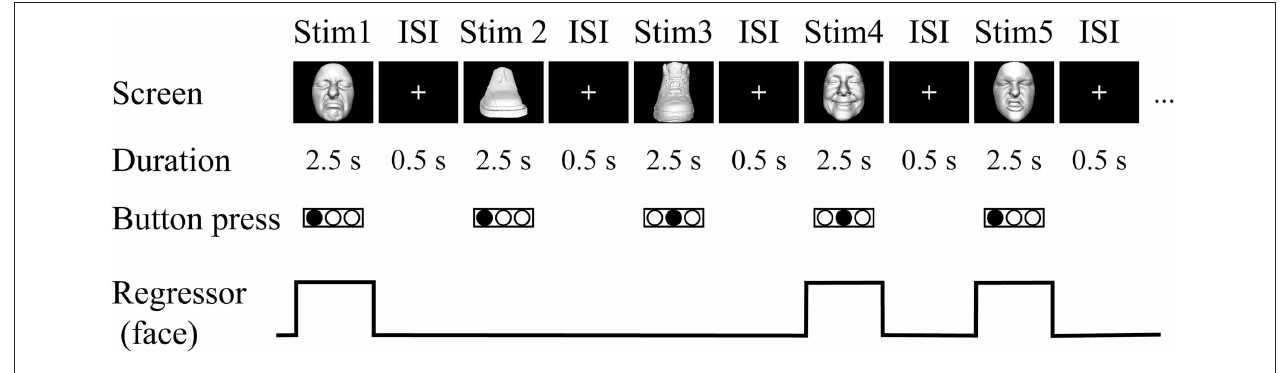
FIGURE 2 | Visual task. In the fMRI experiment, sighted subjects were instructed to identify the three subordinate levels for both object categories by pressing one of three buttons on the response